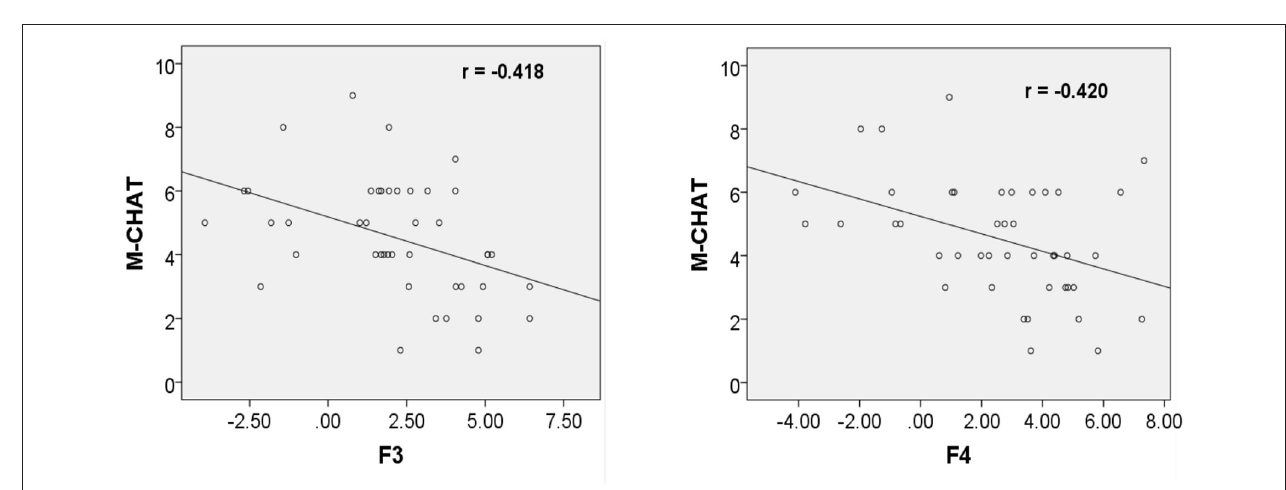
FIGURE 3 | Correlation between ERP amplitudes at F3/F4 in response to fearful prosody and M-CHAT score at 24